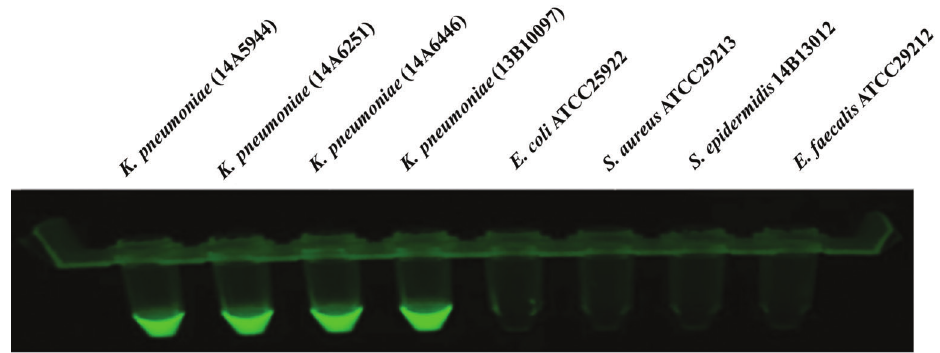
Figure 4. The fl uorescence visualization of the loop-mediated isothermal ampli fi cation (LAMP) speci fi city reaction tubes. Speci fi city of the LAMP assay for detecting the target gene of ureR_1 . Genomic DNA was used as the template for the LAMP. The results were observed under UV-light. All experiments were repeated twice.